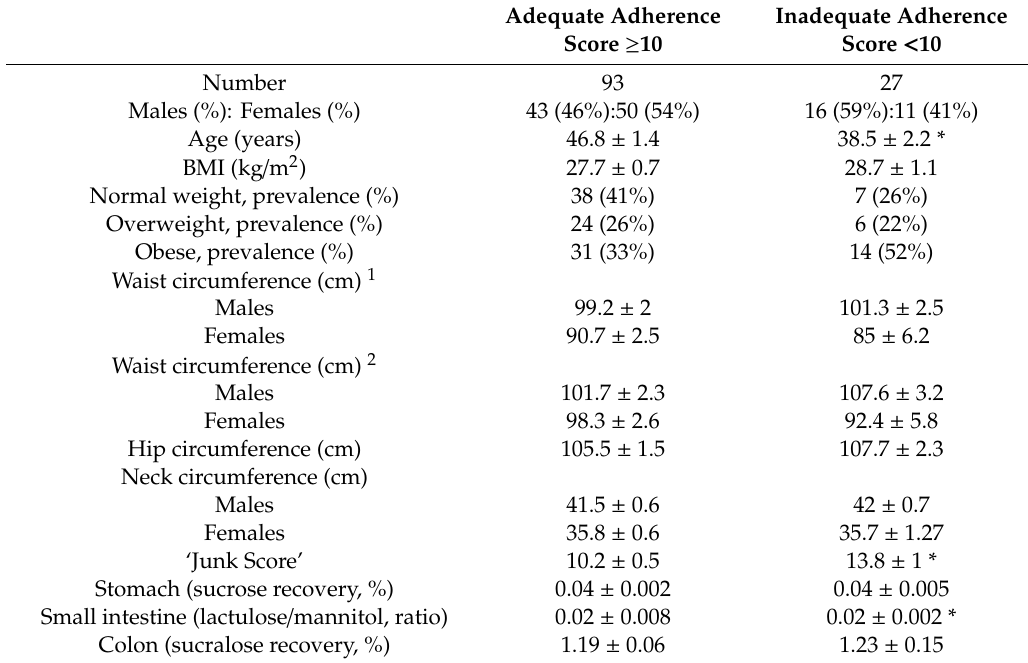
Table 4. Anthropometric features, ‘Junk Score’, and intestinal permeability according to adherence to Mediterranean Diet